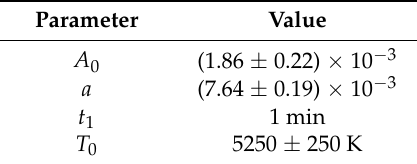
Table 1. Previously obtained ICC fit parameter values [17].